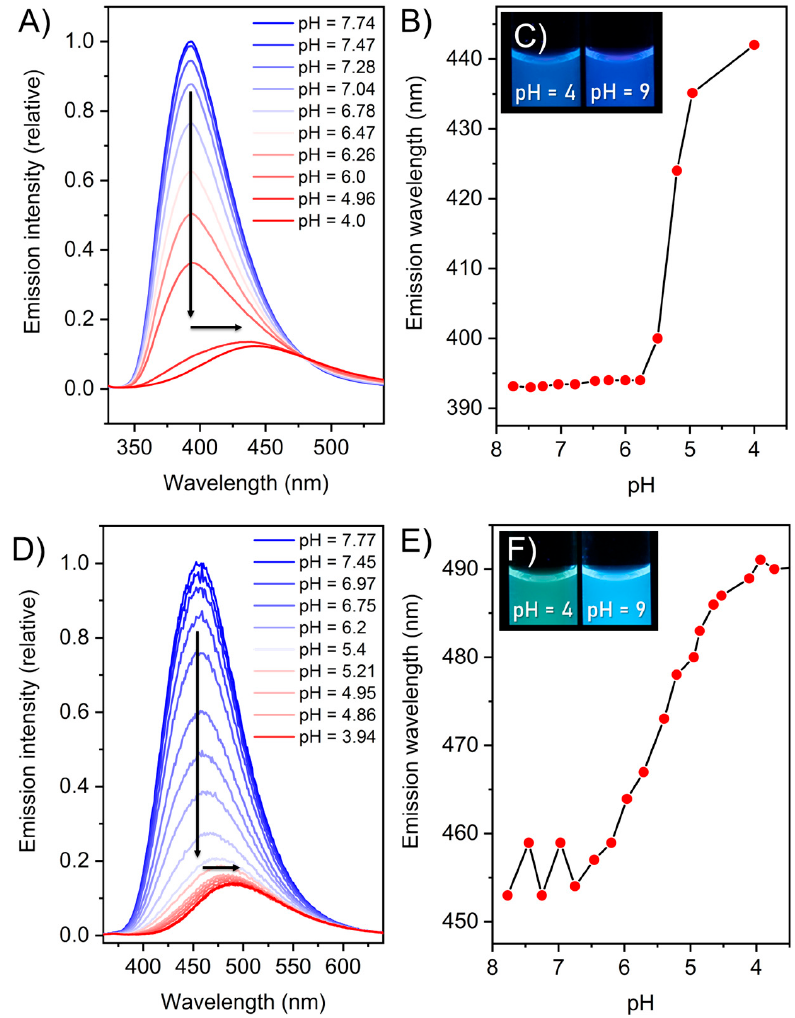
Figure 5. ( A ) Emission spectra of ( 2 ) at different pH values, blue = high pH, red = low pH. ( B ) Emission maximum of ( 2 ) plotted against the pH value. ( C ) Photograph of compound ( 2 ) at pH = 4 and pH = 9 under UV-irradiation ( λ ex = 365 nm) (100 µM, bis-tris buffer 6 mM). ( D ) Emission spectra of ( 3 ) at different pH values, blue = high pH, red = low pH. ( E ) Emission maximum of ( 3 ) plotted against the pH value. ( F ) Photograph of compound ( 3 ) at pH = 4 and pH = 9 under UV-irradiation ( λ ex = 365 nm) (100 µM, bis-tris buffer 6 mM).